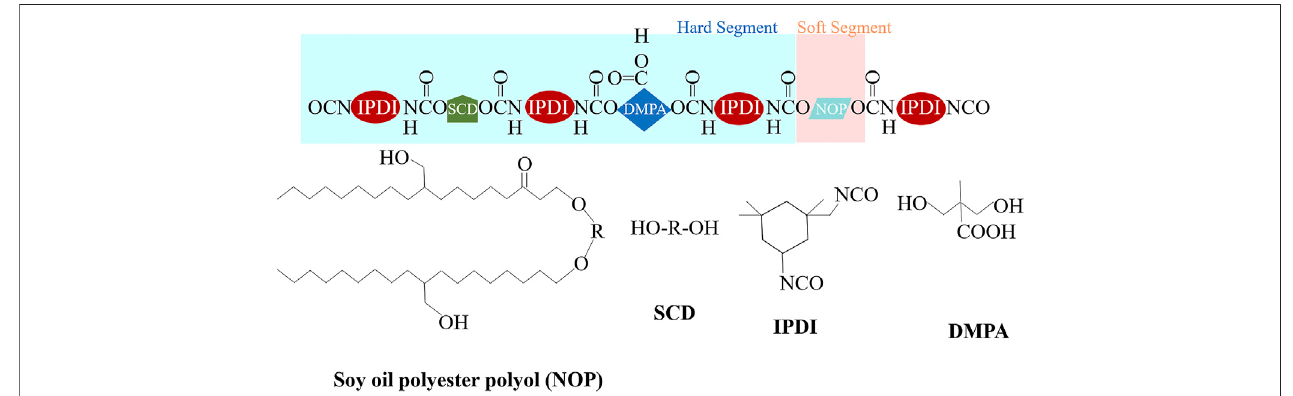
FIGURE 12 | Schematic illustration of structure of